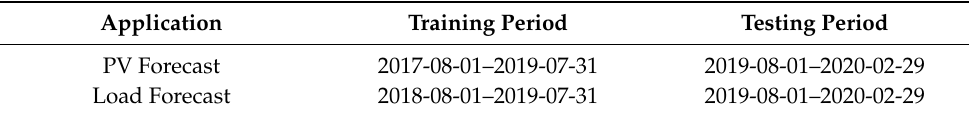
Table 1. Training and testing periods for Net Load Forecast